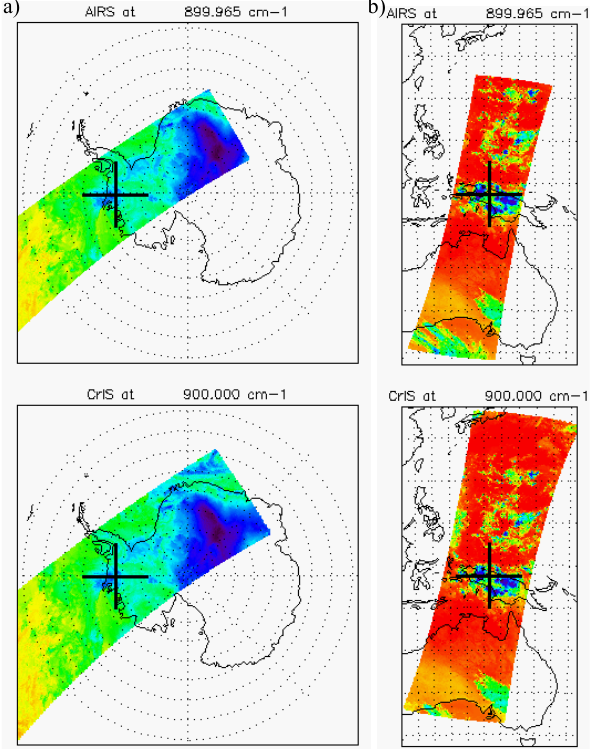
Table 2. Collocation criteria for CrIS–AIRS and CrIS–IASI SNOs.